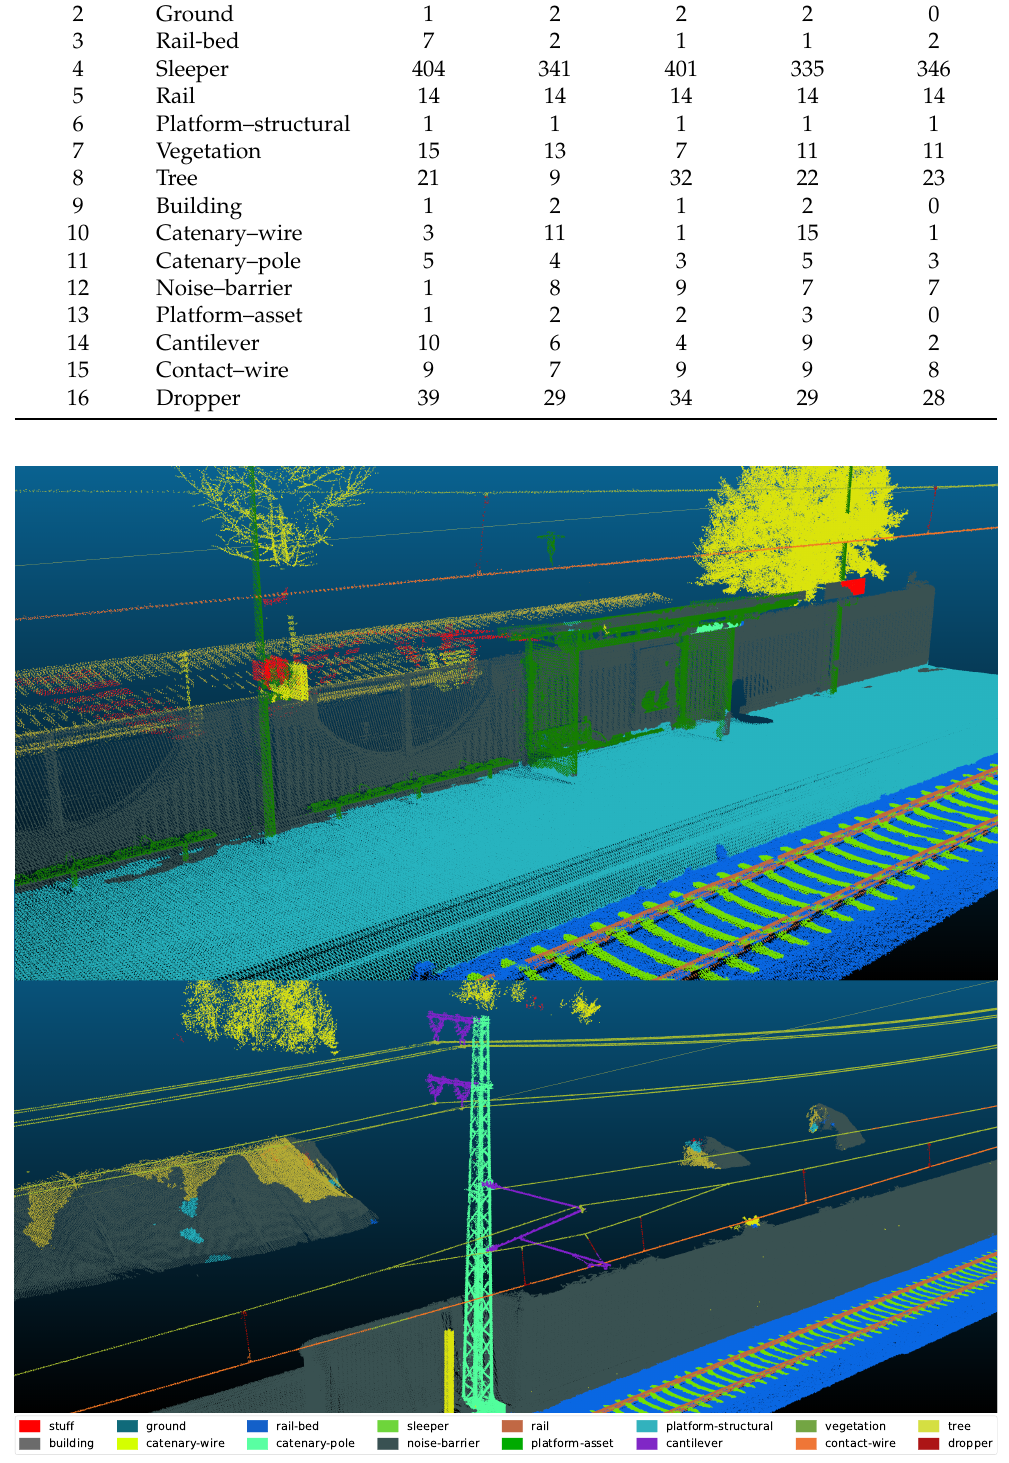
Figure A1. Results of the finetuned model on the real dataset. Considering the neural model has not seen any “real” shelters, the results are